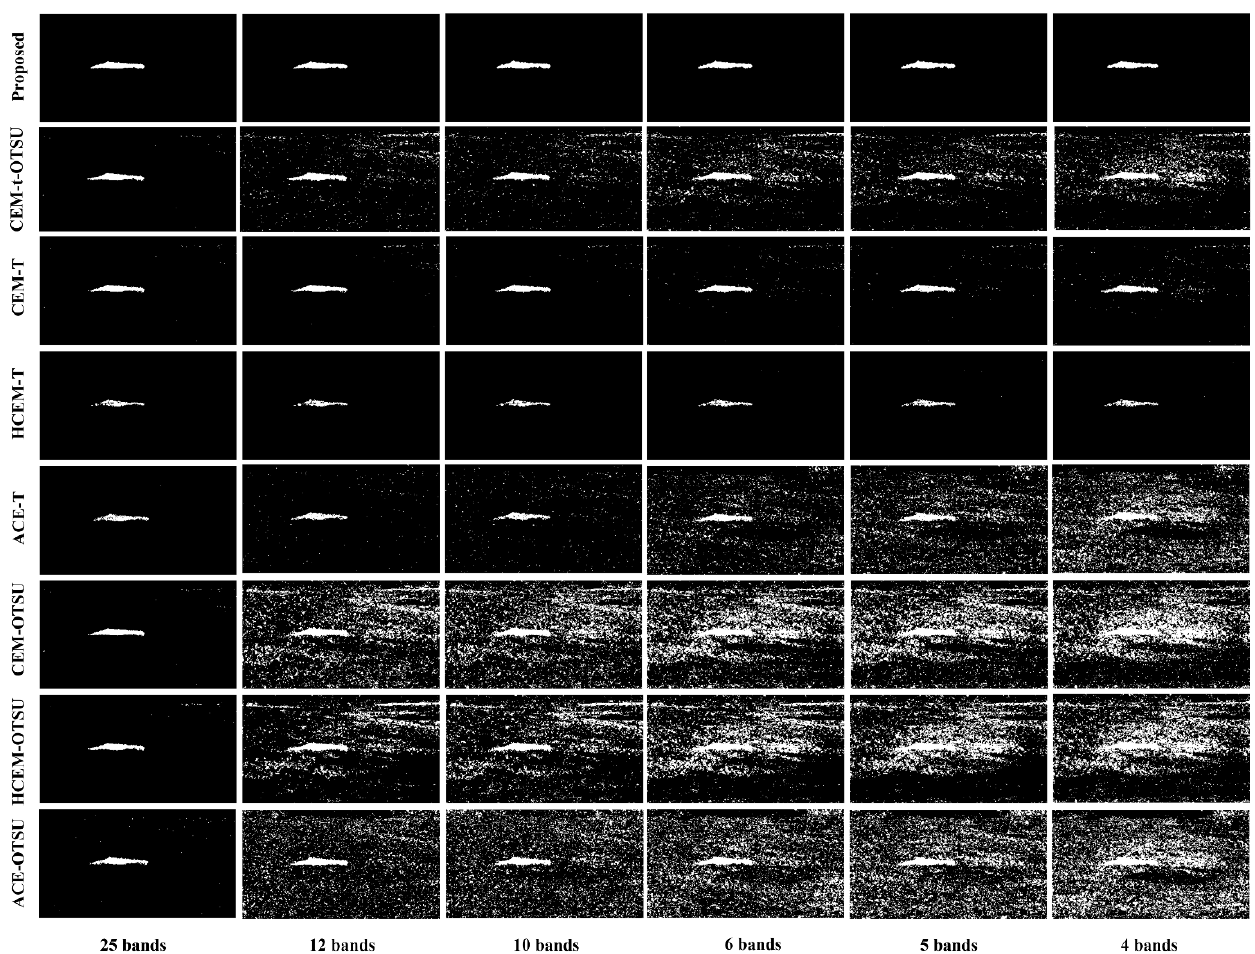
Figure 6. The detection results of different methods for the ASRC-net in the Lawn scene with bands ranging from 4 to 25. All the results are normalized to the range [0,1] for a fair comparison.